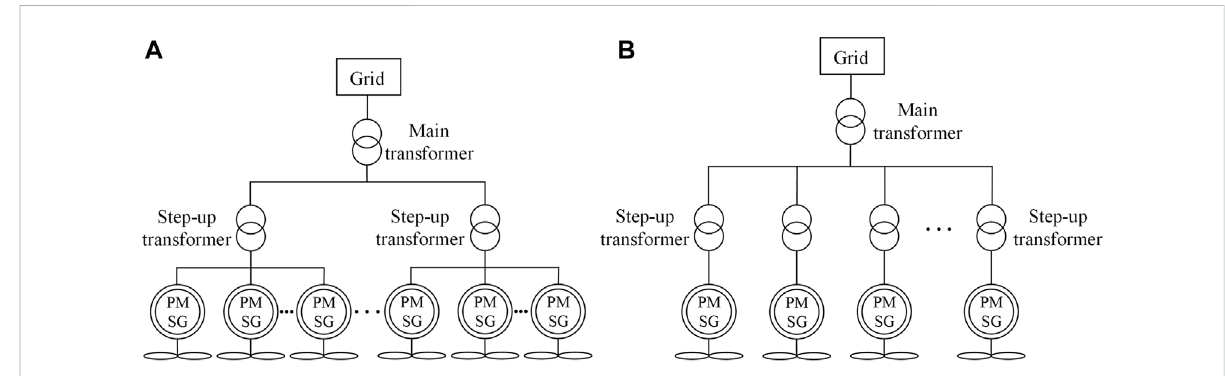
FIGURE 6 Schematic diagram of the connection of the collector system shows two different connections of the wind farm collector system to facilitate the equivalence calculation of the parameters of the subsequent collector system (A) For multiple wind turbines sharing one transformer. (B) One transformer for one wind